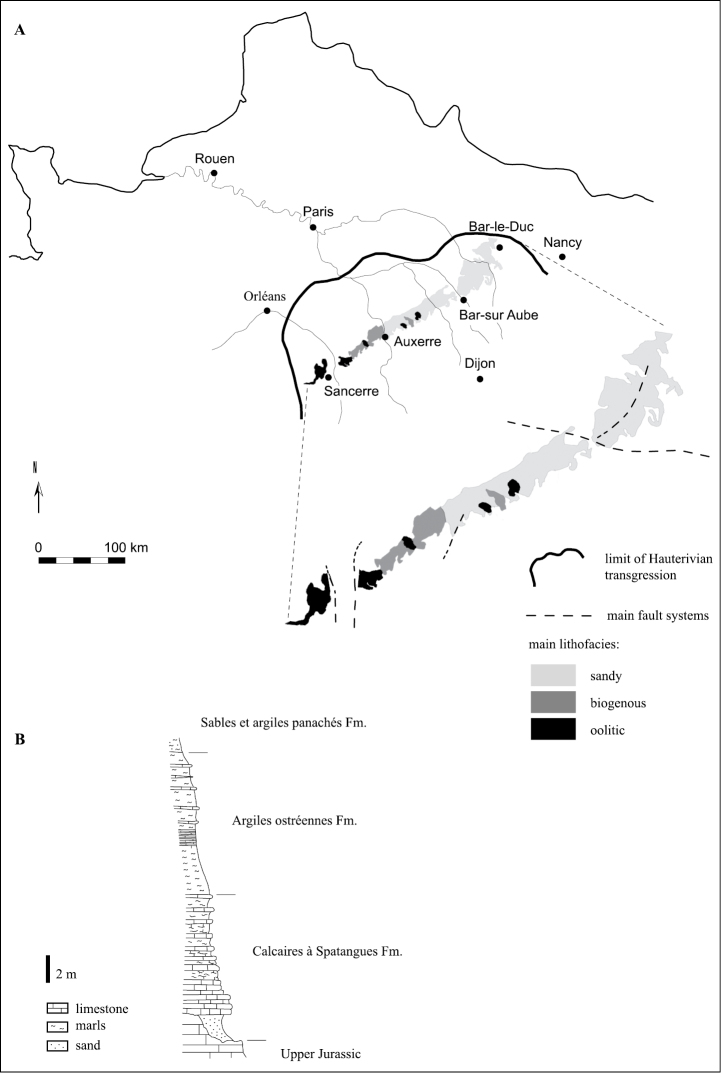
Geographic, geologic, and stratigraphic settings. A. Map showing the area of the Paris Basin (France) where the Calcaires à Spatangues Fm. crops out (modified after Courtinat et al. 2006 and Saucède et al. 2012). Distribution of main lithofacies as defined by Rat et al. (1987). B. Calcaires à Spatangues Fm. section at Lantages 48°08'N, 4°24'E (modified after Rat et al. 1987).